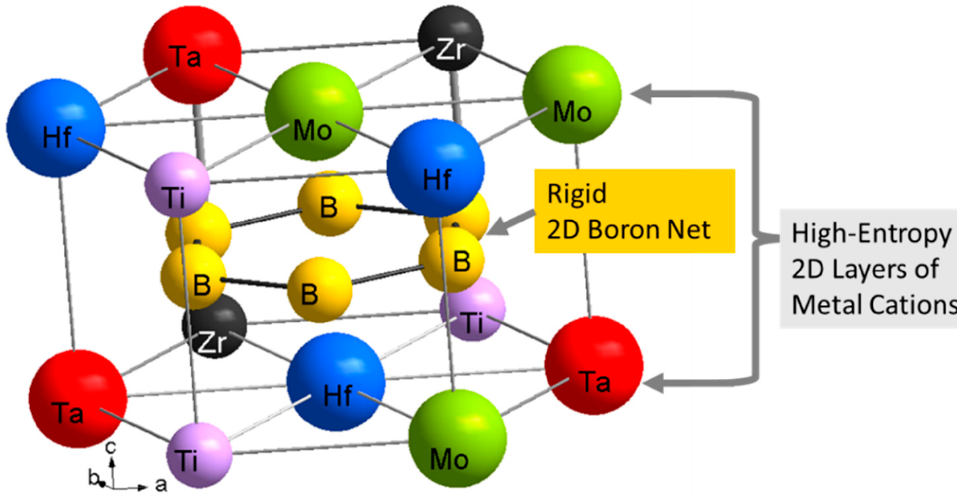
Figure 1. Schematic of a typical high-entropy boride crystal structure (hexagonal AlB 2 -type) showing a rigid 2D boron net and metal cations sites that are randomly occupied by the five transition metals.